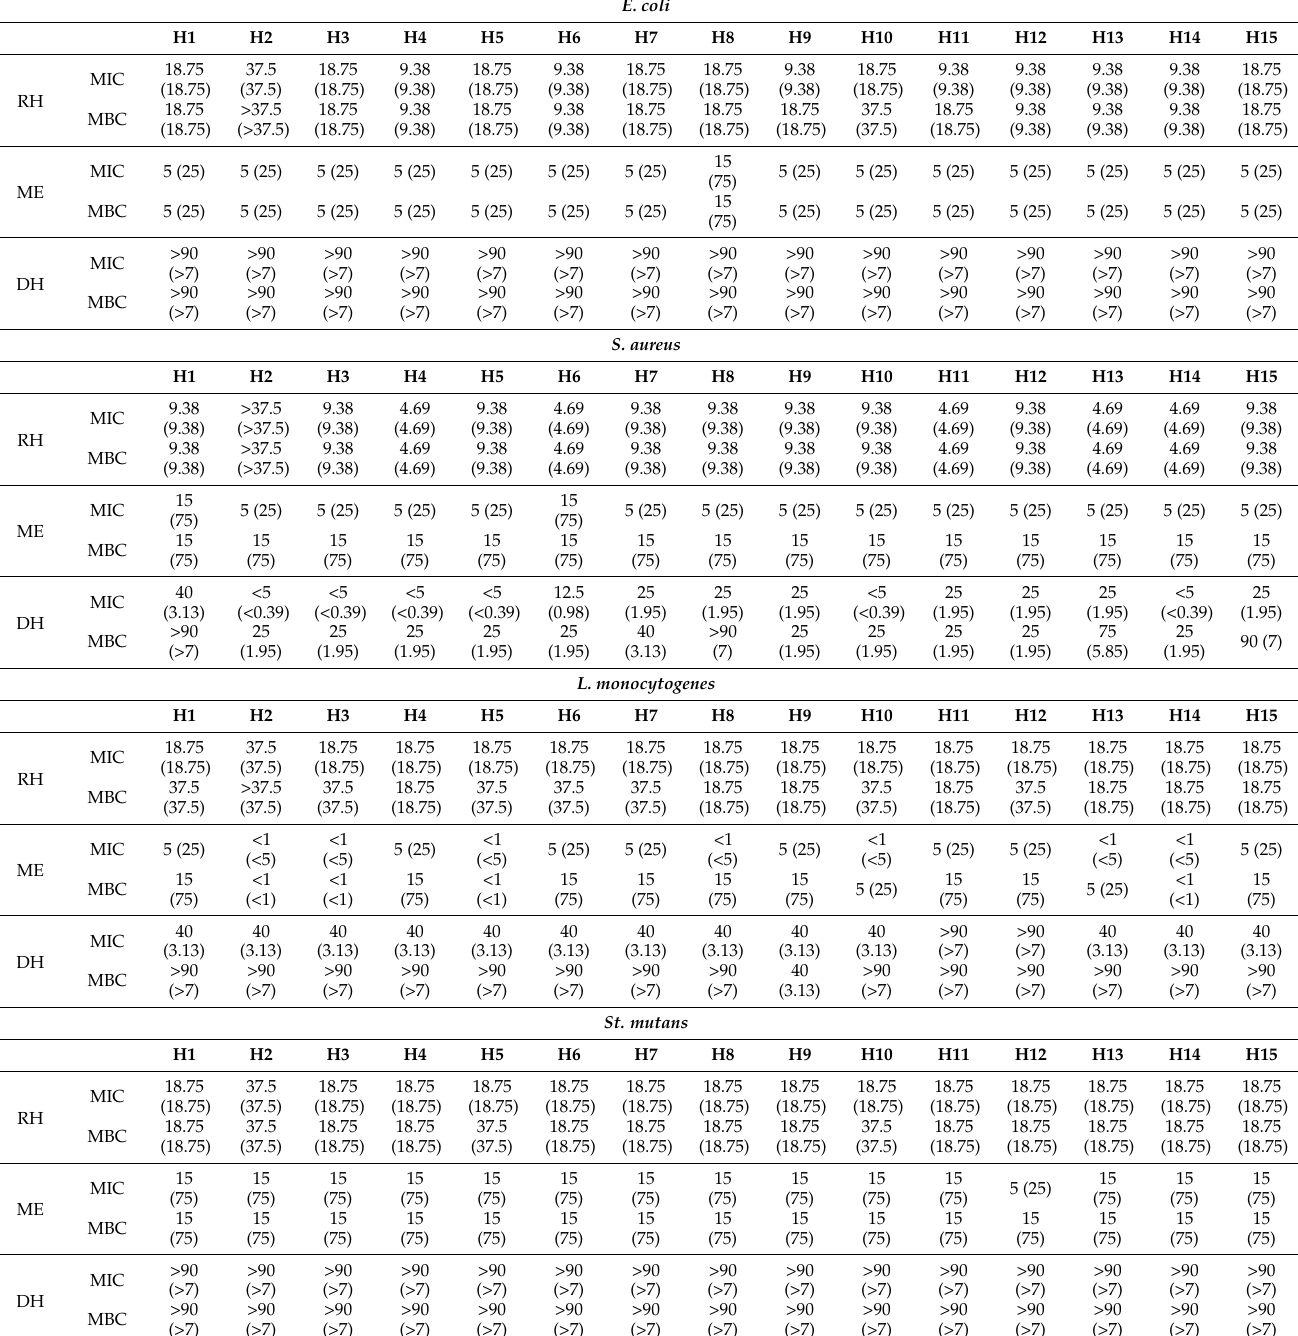
Table 2. Minimal inhibition concentration (MIC) and minimal bactericidal concentration (MBC) of raw honeys (RH), methanolic honey extracts (ME) and honey after in vitro digestion (DH) expressed as % of honey, extract or digestive fraction and between brackets the corresponding honey concentration (g/100 mL). Triplicated showed identical MIC or MBC for each sample. Different MIC or MBC values indicate significant differences ( p < 0.05) between samples with the same extraction for each